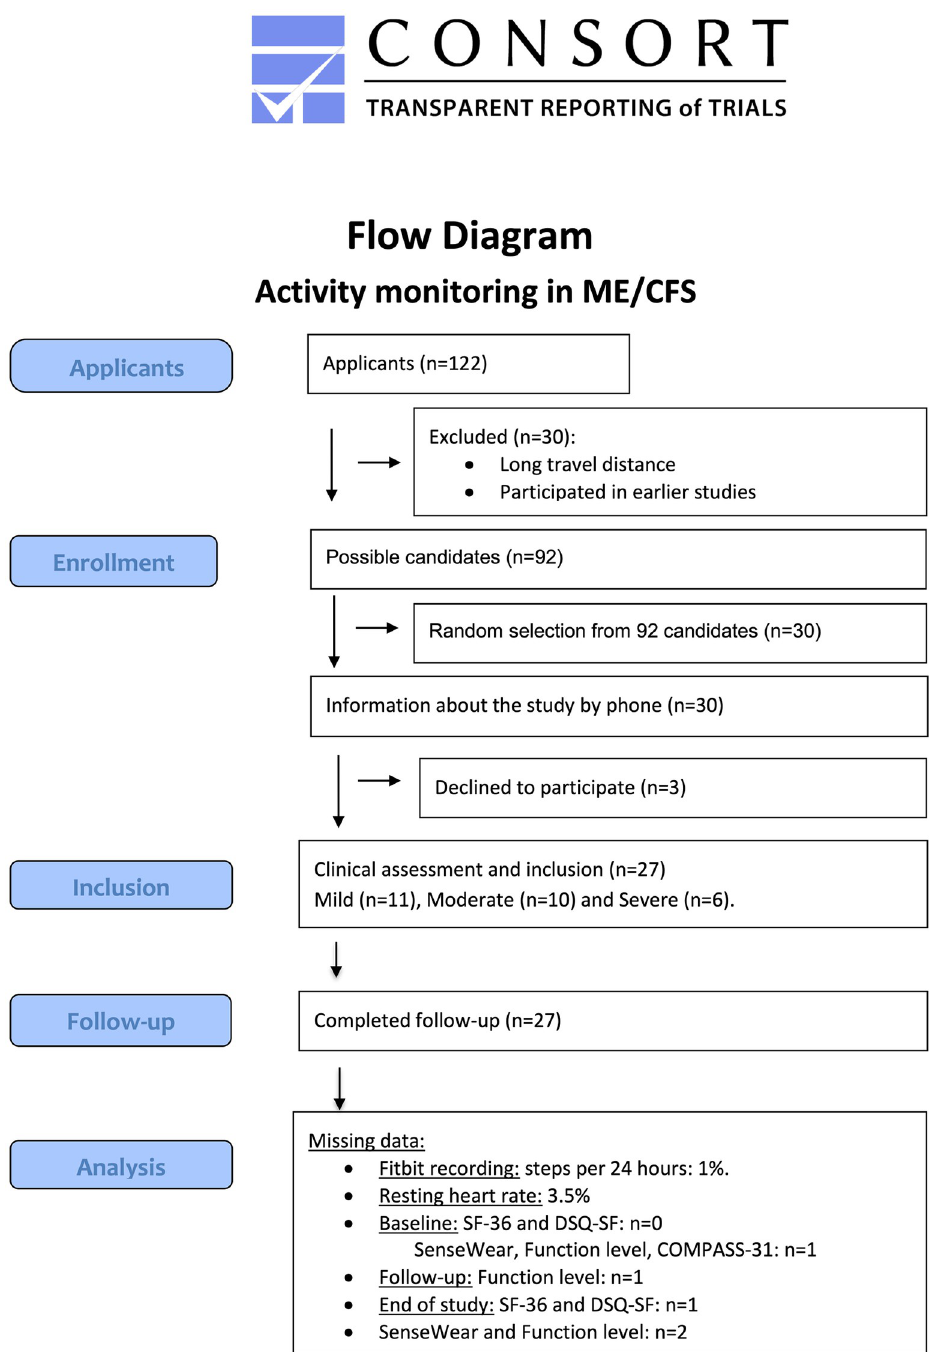
Fig 1. CONSORT flow diagram. Flow diagram of enrollment, follow-up and analysis in the study “Activity monitoring in ME/CFS”.